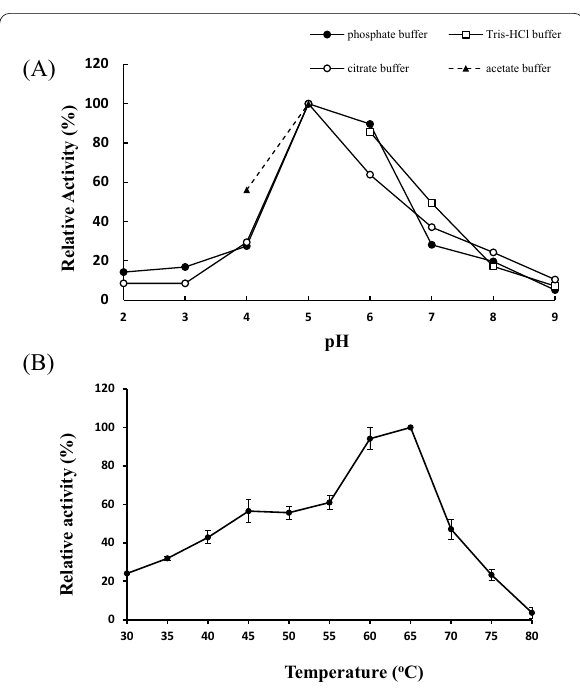
Fig. 3 Optimal pH and temperature of TvmNAG2. A To determine the optimal pH of TvmNAG2, NAGase activity assay was performed at various pH of buffer (final 41.7 mM) including citrate buffer, acetate buffer, Tris buffer or phosphate buffer at 65 °C for 30 min. B To determine the optimal temperature of TvmNAG2, NAGase activity assay was performed at different temperature, 30–80 °C for 30 min at pH 5